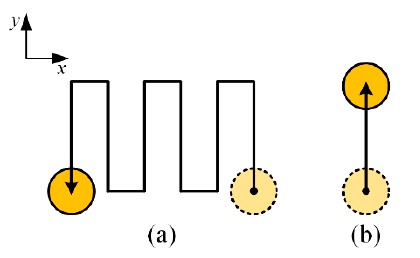
Figure 2. Schematic diagram of ( a ) milling paths in one layer and ( b ) straight-line milling path.